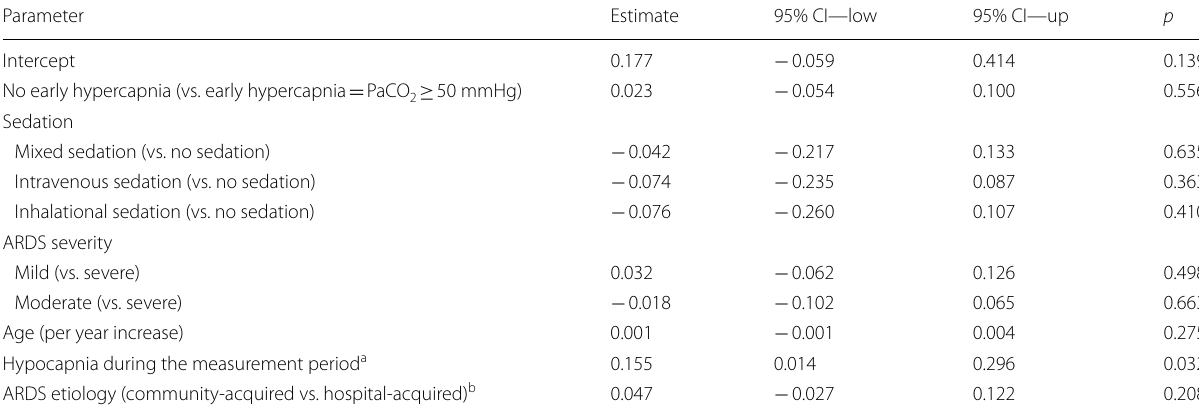
Table 3 Linear mixed model—estimates of fixed effects